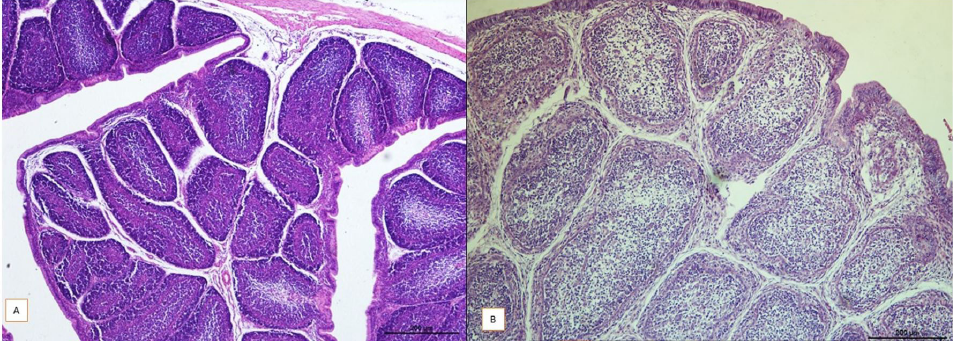
Figure 1. Bursa histology of 21 and 42 days old birds receiving Rhizomucor spp. in the diet. A: Normal bursa of 21-day-old birds, B: Bursa with slight reduction in cellularity in the 42-day-old lymphoid follicles. (scale: 200 μ m).